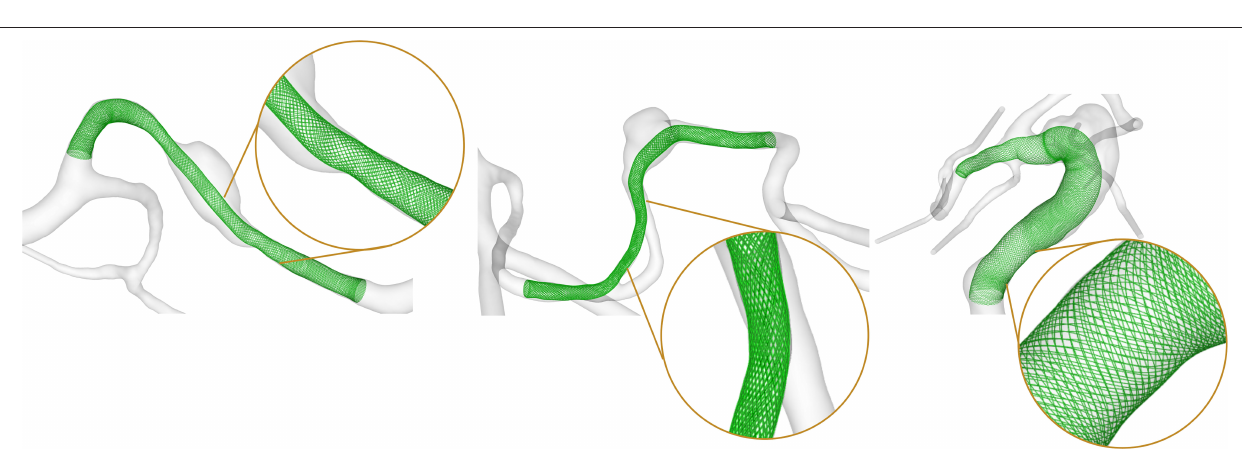
FIGURE 2 | Results of the virtual flow-diverter deployment for Case 1 (left), Case 2 (center), and Case 3 (right). Inlays show the explicit resolution of the braided stent structure allowing for a precise evaluation of the post-interventional hemodynamic state.